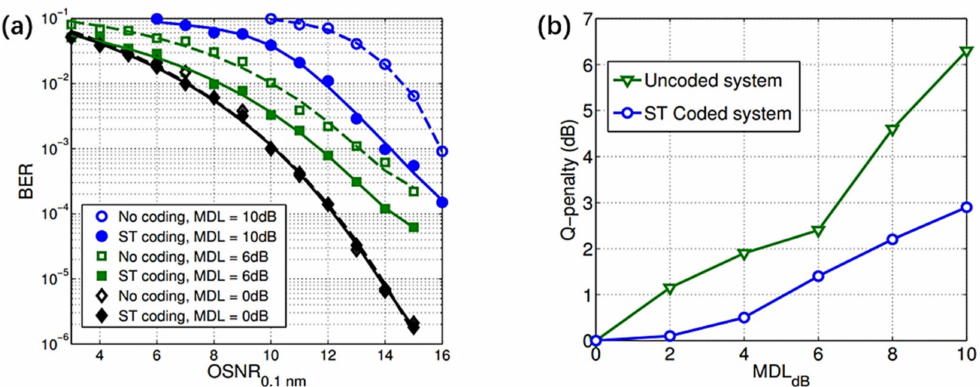
Figure 13. ( a ) BER vs. OSNR for ST coded and uncoded transmission for MDL = 0, 6, 10 dB ( b ). Q penalty vs. MDL at OSNR = 14 dB with regards to the MDL-free